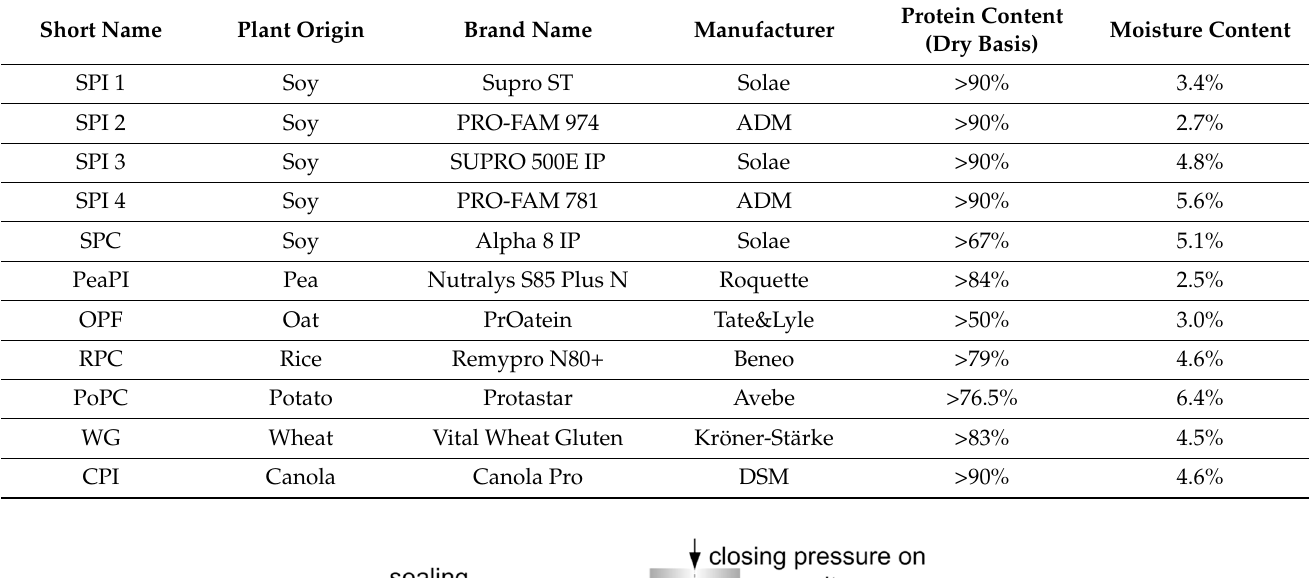
Table 1. List of investigated plant-based raw materials.